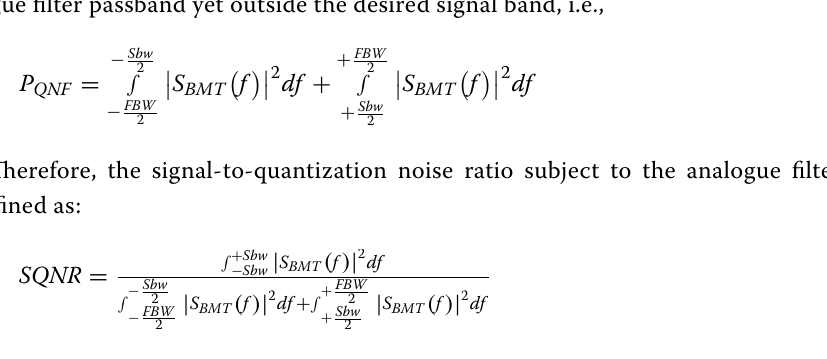
Fig. 4 Simulated spectrum of CANE with EDSM. a Two-channel CANE with delay CANE with delay increment 30 nS, uniform weighting =